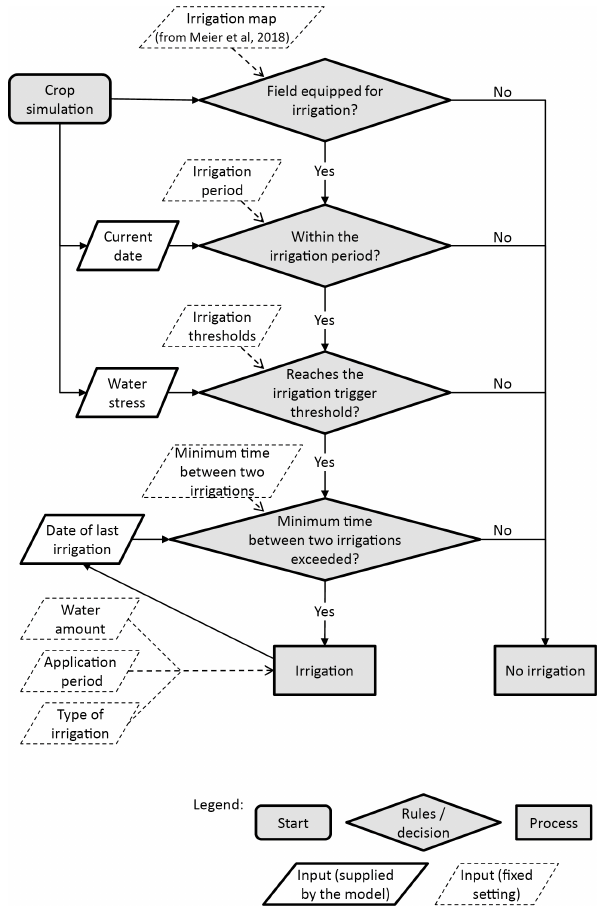
Figure 1. Irrigation decision tree